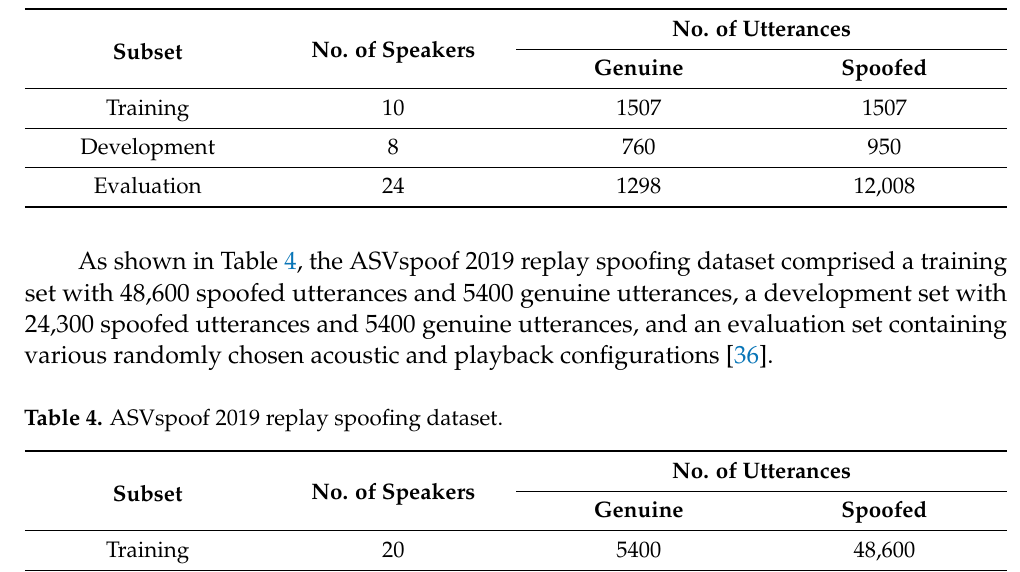
Table 3. ASVspoof 2017 V.2.0 dataset.